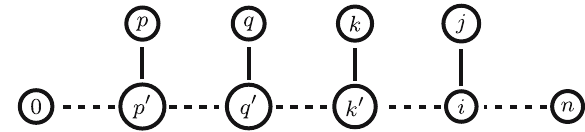
Figure 24: Minimum subgraph of C containing vertices